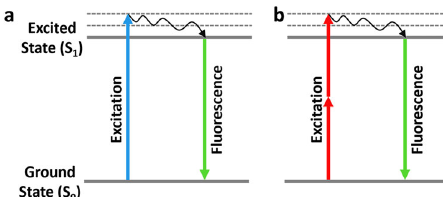
Fig. 1 Simpli fi ed Jablonski diagram for single-photon and two-photon excitation. a Single-photon excitation (blue line) occurs by the absorption of a single photon of light providing suf fi cient energy to reach the excited state. b Two-photon excitation (red line) occurs by simultaneous absorption of two-photon of lower energy. In both cases, subsequent fl uorescence emission (green line) emerges when the photons return to the ground